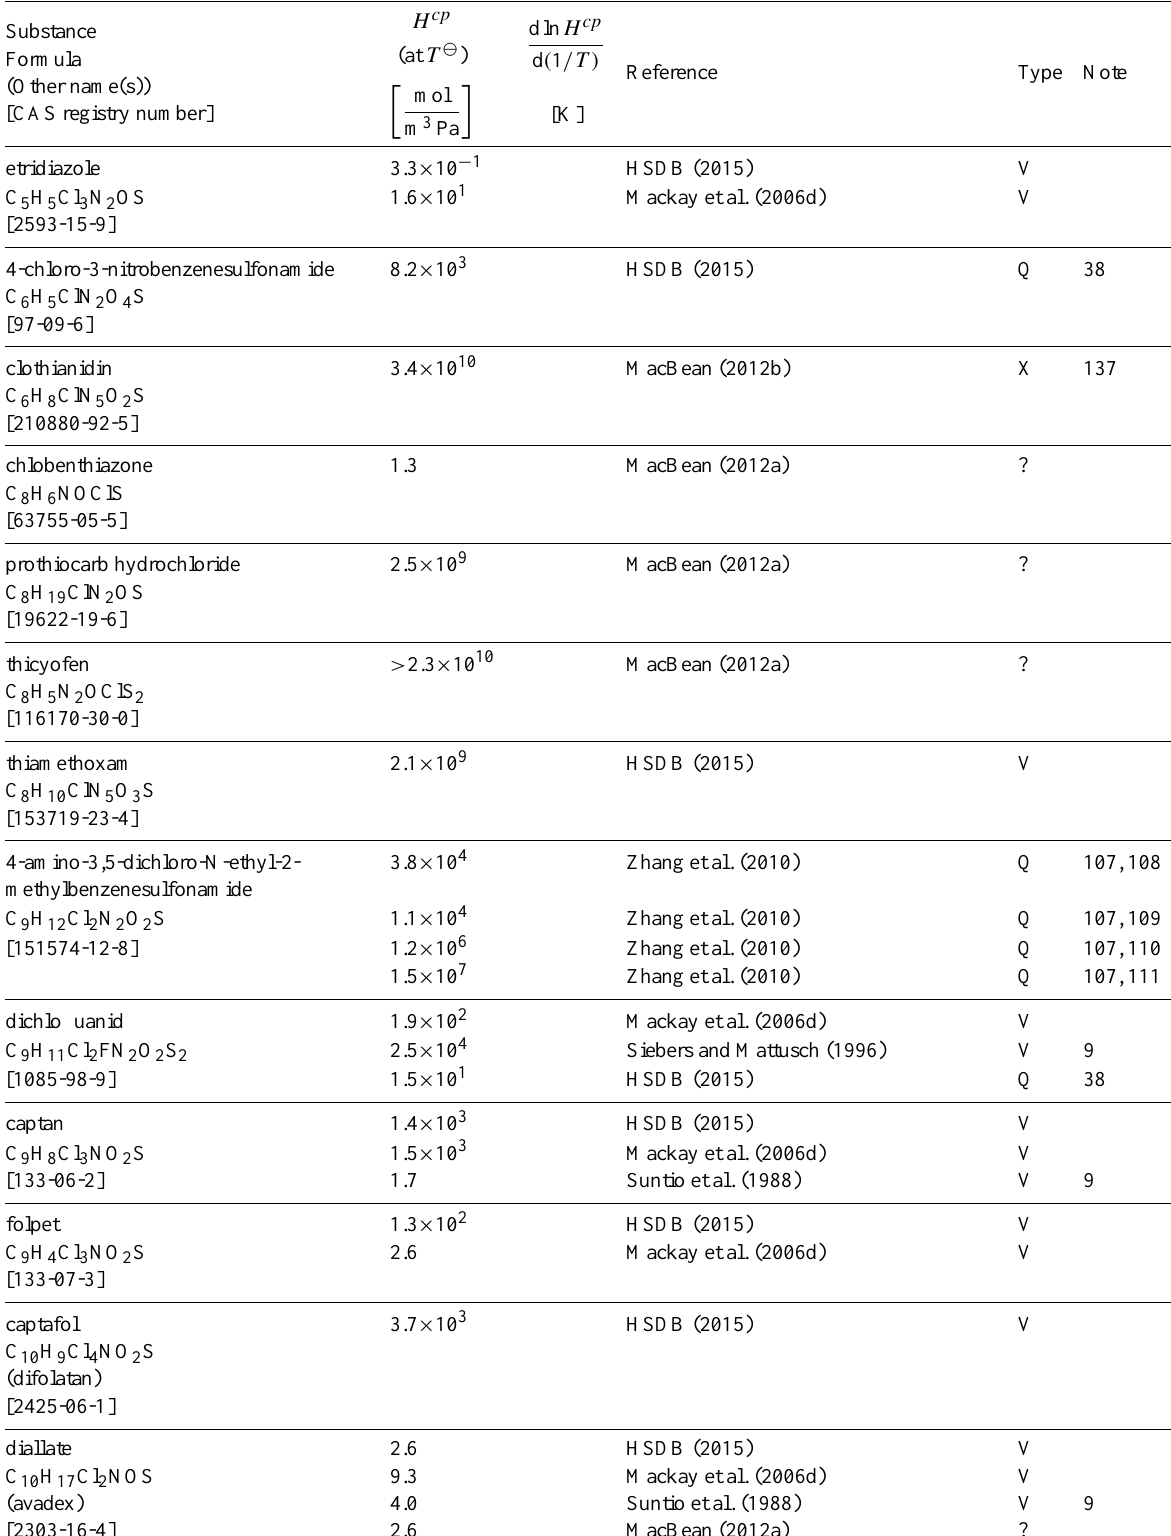
Table 6: Henry’s law constants for water as solvent